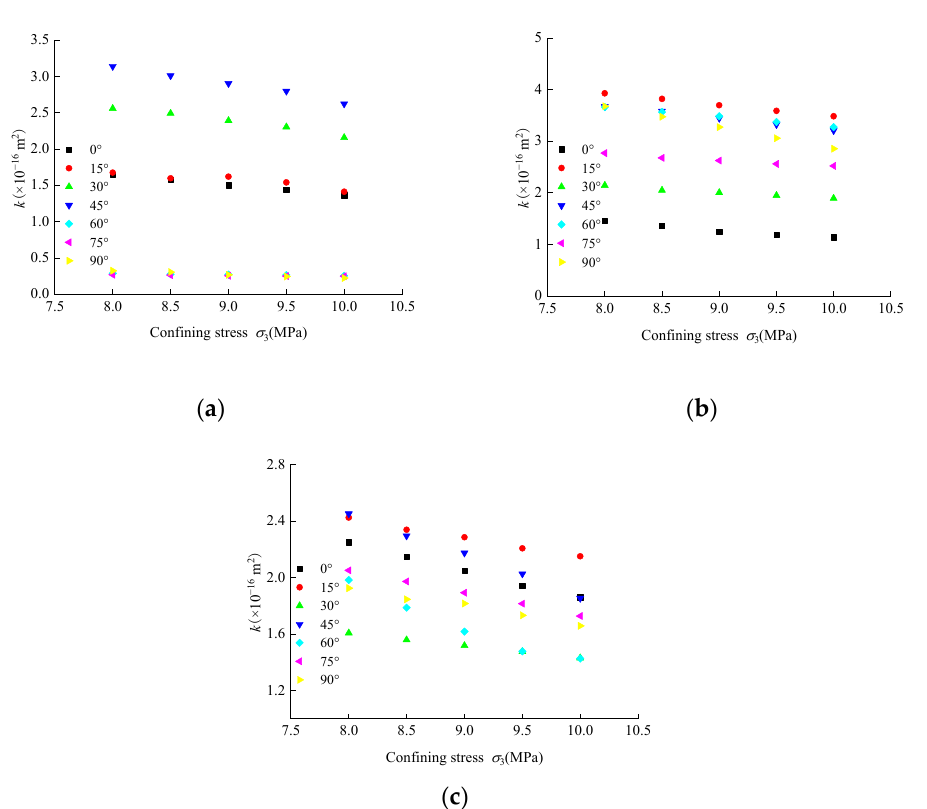
Figure 9. Variation characteristics of inherent permeability with the confining pressure under different inclinations and fractures: ( a ) Single fracture; ( b ) T ‐ shaped fracture; ( c ) Y ‐ shaped fracture. In order to determine the linear term coefficient a and non ‐ linear term coefficient b for rock porous or fractured media, intrinsic permeability k and non ‐ Darcy coefficient β are essential parameters. The literature claims that there is a direct relationship between k and β [8,10,11,34,43]. When β is a positive value, it has been common practice to employ the power function relationship between β and k for porous or fractured media. The fit ‐ ting study of the correlation between β (negative value) and k in pore ‐ fracture media in the paper also yields the power function relationship.